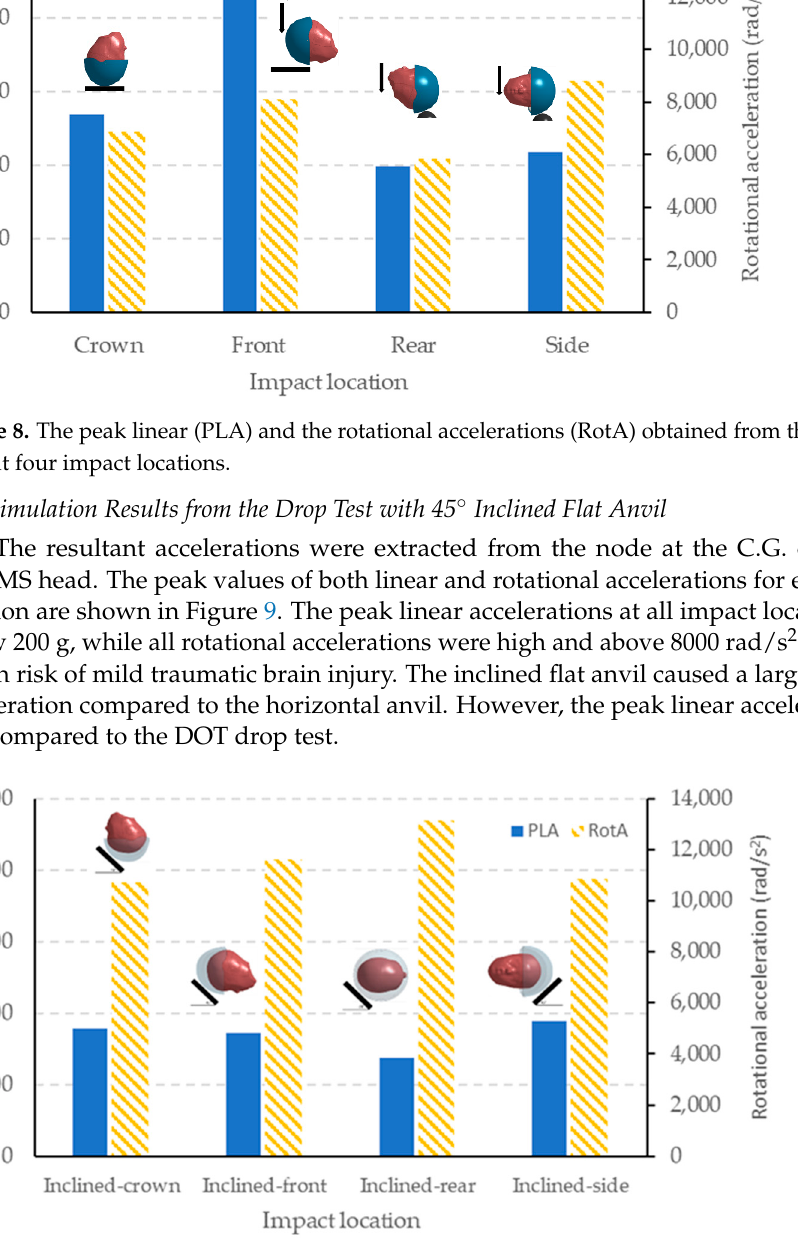
Figure 9. The peak linear (PLA) and the rotational accelerations (RotA) obtained from the inclined drop tests at four impact locations.